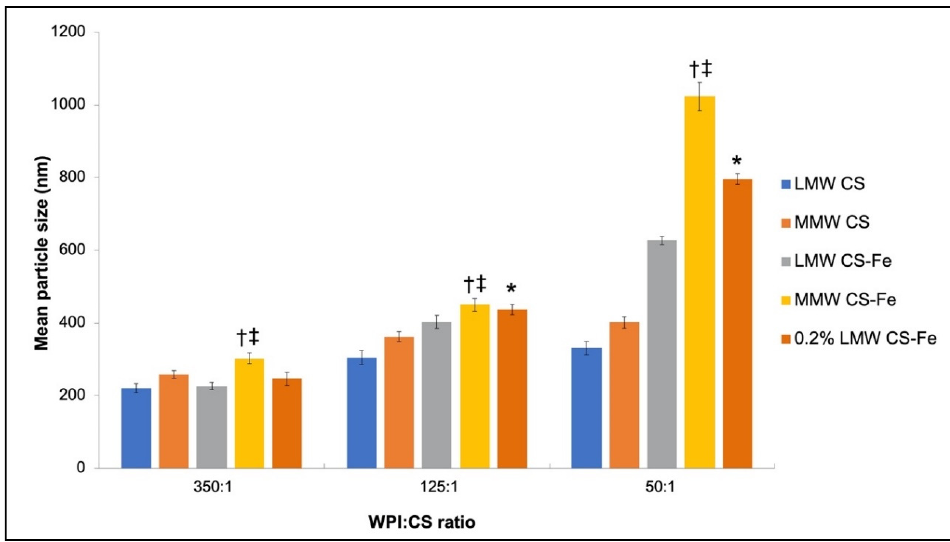
Figure 8. Particle size of iron-entrapped WPI nanoparticles when using different MWs and concentrations of chitosan at various WPI:CS ratios. Results are shown as mean ± SD (n = 10). Data were considered statistically different when p < 0.05. * indicates a significant difference between LMW CS-Fe and 0.2% LMW CS-Fe at the same ratio, † indicates a significant difference LMW CS-Fe and MMW CS-Fe at the same ratio, ‡ indicates a significant difference between MMW CS and MMW CS-Fe at the same ratio.